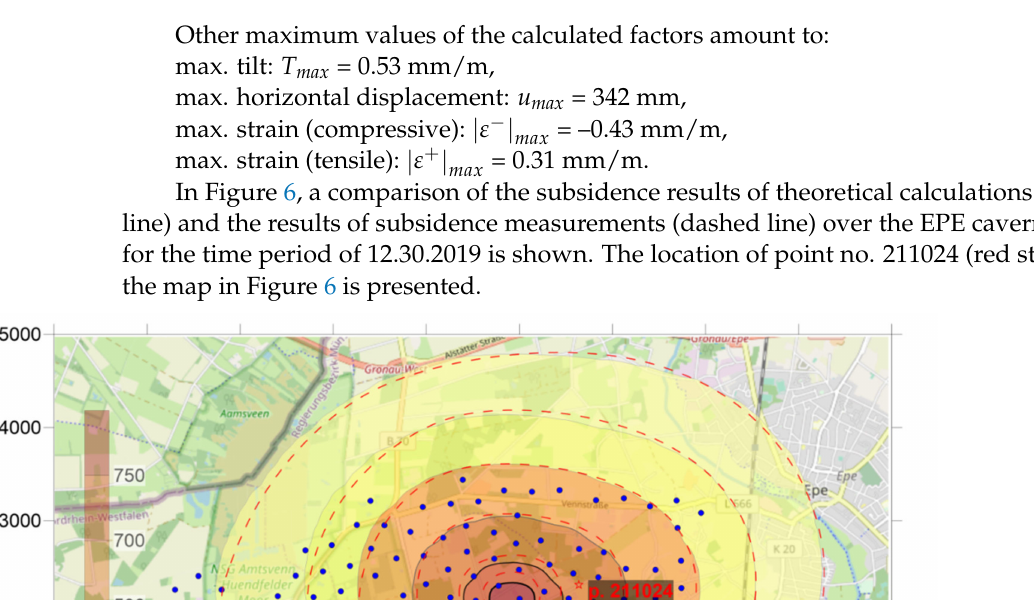
Figure 5. Comparison between theoretical (line with squares) and measured subsidence (line with circles) for the levelling point no. 211024 in the period of 1975–2019.